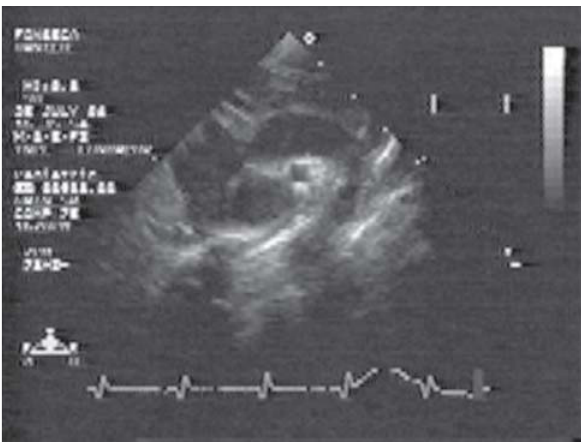
Fig. 9 - Eco-doppler de controle em paciente operado, mostrando arco aórtico após correção cirúrgica sem estenose